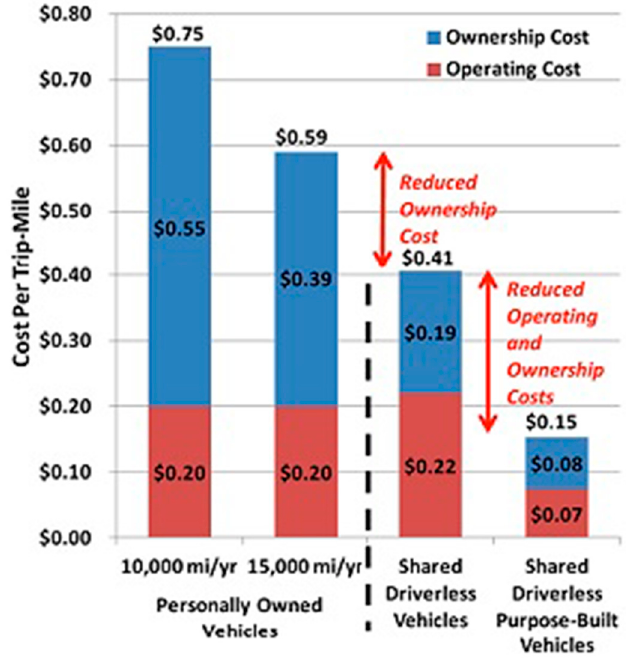
Figure 3. Cost reduction by shared cars [1].